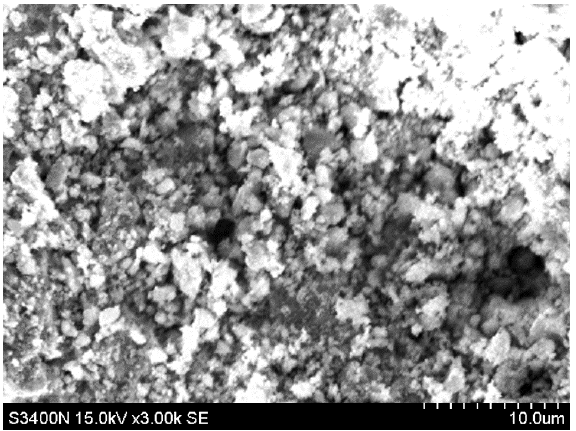
Figure 19. SEM image of the microstructures 20 mm below the inner coating of the substrate when W/C = 0.6 (3000×; 4C2, 56 days).